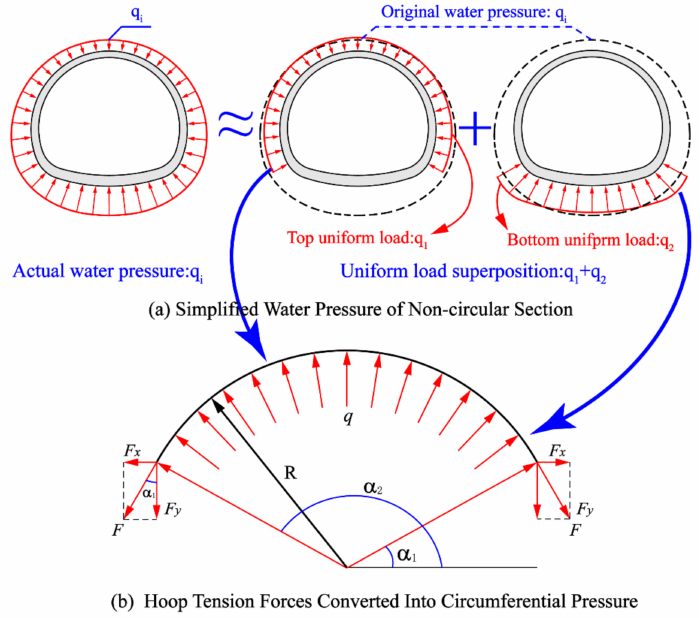
Figure 2. Principle of equivalent water-pressure loading for noncircular cross